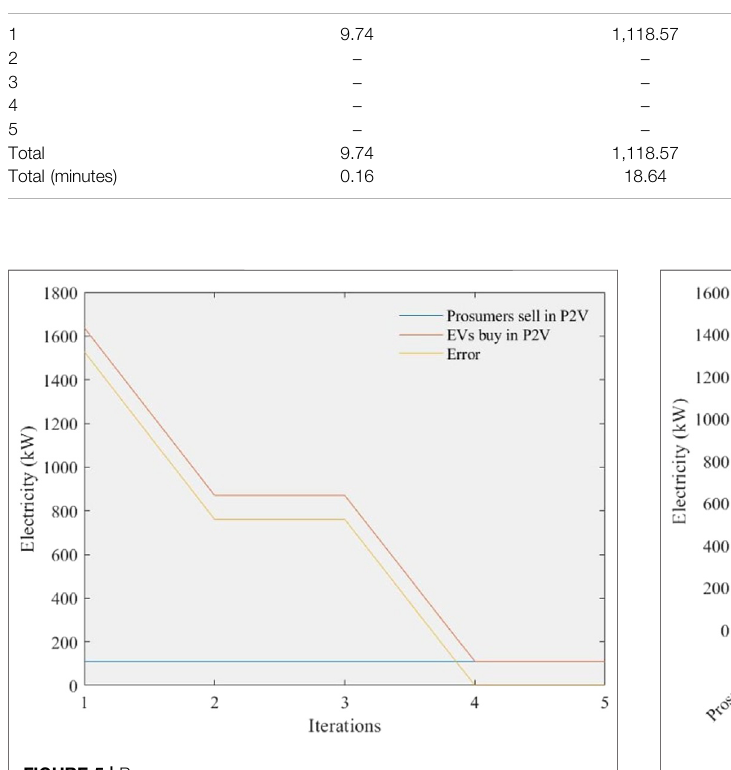
FIGURE 5 | Process convergence. FIGURE 6 | Buys and sells of scenario B.